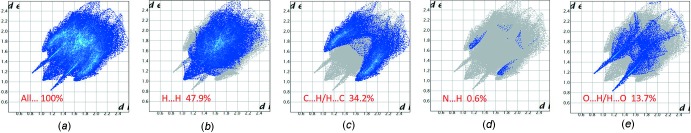
(a) Two-dimensional fingerprint plot of the title compound, and those delineated into (b) H⋯H, (c) C⋯H/H⋯C, (d) N⋯H/H⋯N and (e) O⋯H/H⋯O inter­actions.